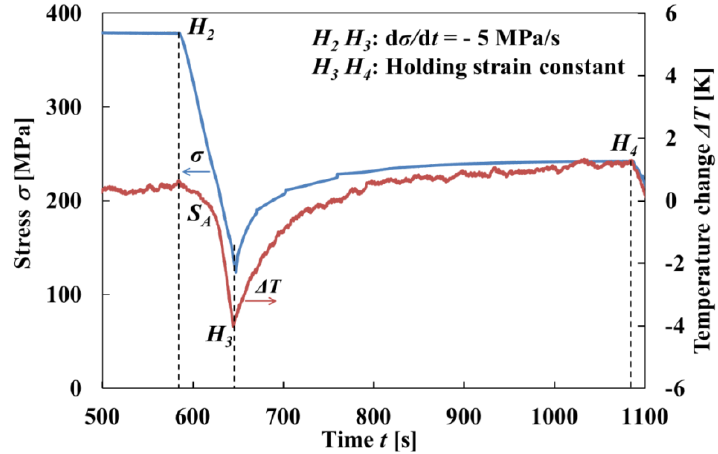
(ε = 2%) and 3 3 to point H . 3 4